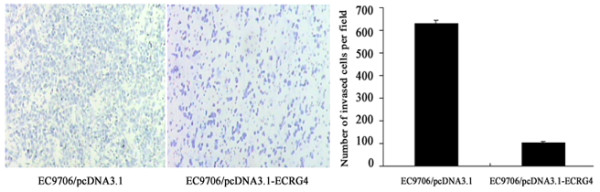
Effect of ECRG4 overexpression on tumor cells invasion. Representative photos and statistic plots of invasion assay in EC9706/pcDNA3.1-ECRG4 and EC9706/pcDNA3.1 cells (×200). The number of EC9706/pcDNA3.1-ECRG4 cells transversed the Transwell membrane was decreased compared with that of EC9706/pcDNA3.1 cells (P < 0.05). Error bars represent standard deviation from mean value.